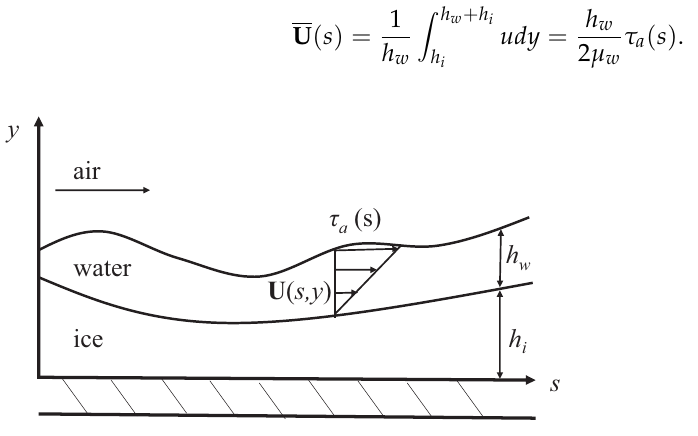
Figure 6. Diagram of water